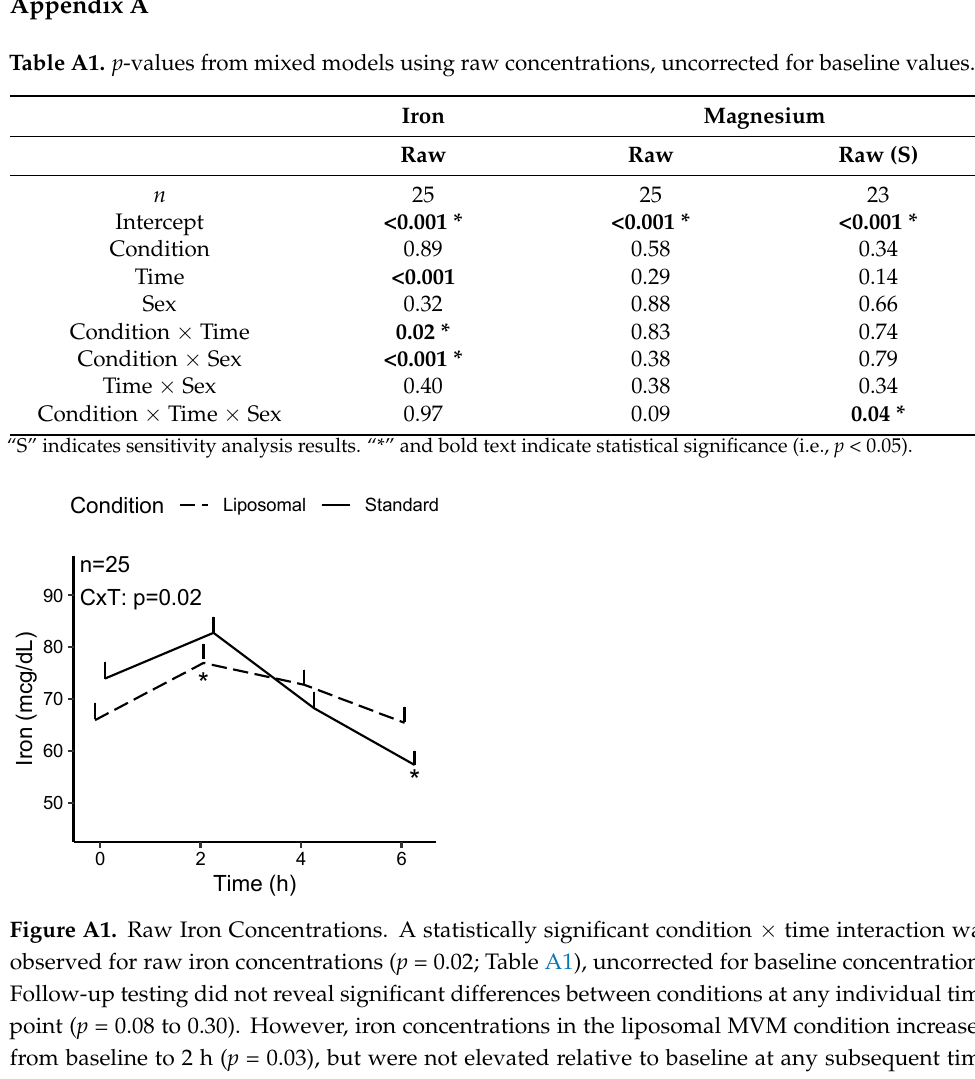
Figure A2. Raw Magnesium Concentrations. No significant condition * time interaction was ob- served for raw magnesium concentrations, uncorrected for baseline values, in the full sample ( A ) or in a sensitivity analysis with extreme outliers removed ( B ). A significant condition * time * sex in- teraction was observed in the sensitivity analysis (Table A1); however, follow-up testing did not